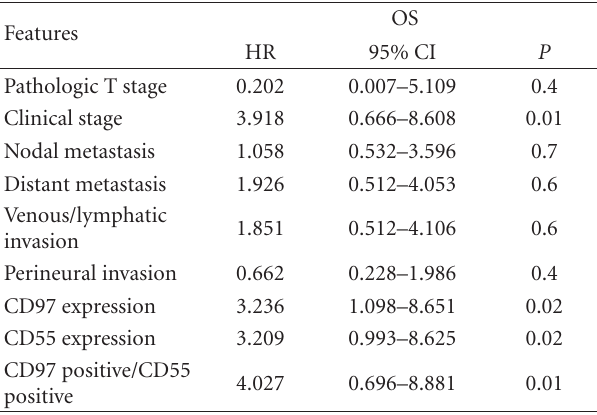
Table 3: Multivariate analysis of the associations of prognosis with various clinicopathologic parameters in patients with